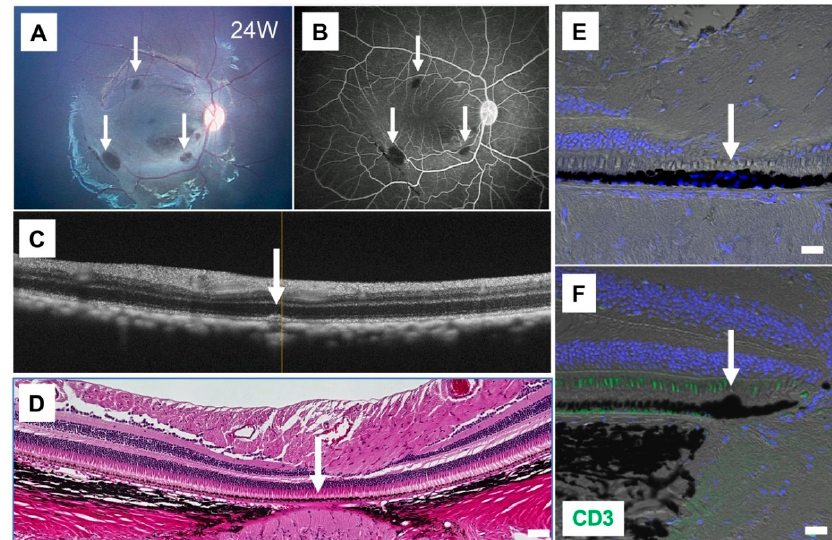
Figure 6. Results of iPSC-RPE transplantation while using cyclosporine A. ( A ) The fundus photograph of monkey HM-5 at 24 weeks after surgery, who was subjected to human iPSC-RPE transplantation with administration of cyclosporine A before the transplantation. Arrows show the transplanted sites. ( B ) Fluorescein angiography (FA) at late phase showed no hyperfluorescence around the grafts (arrows). No FA leakage was observed during the 24-week evaluation period. ( C ) Optical coherence tomography (OCT) showed the presence of cell aggregates of graft cells (arrow) in the subretinal space. ( D ) The graft cells (arrow) but not inflammatory cells were observed in the subretinal space by H&E staining. Scale bar: 50 μ m. ( E – F ) IHC with CD3 (green) and DAPI (blue). RPE grafts were detected in the subretinal space (arrows). CD3 + T cells were not observed in the retina ( F ). Scale bars: 20 μ m.